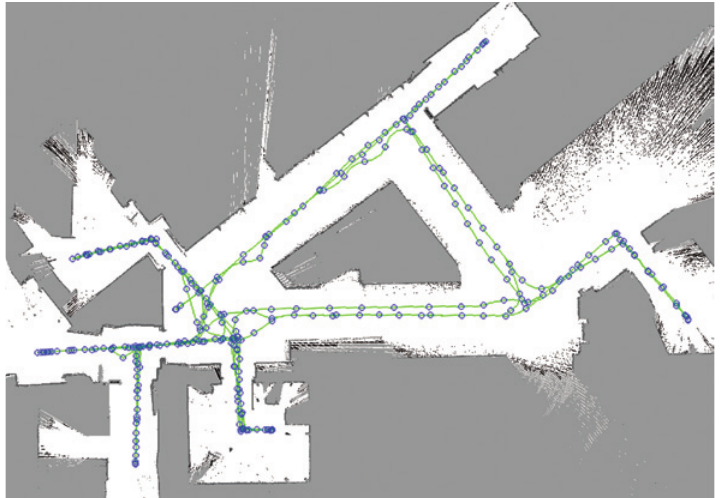
Figure 12. A Large Topometric Map in a Six-Room Environment Showing the Consistency of the Produced Map (“6 Rooms” Sequence, 1325 Images, 352 Loop Closures).